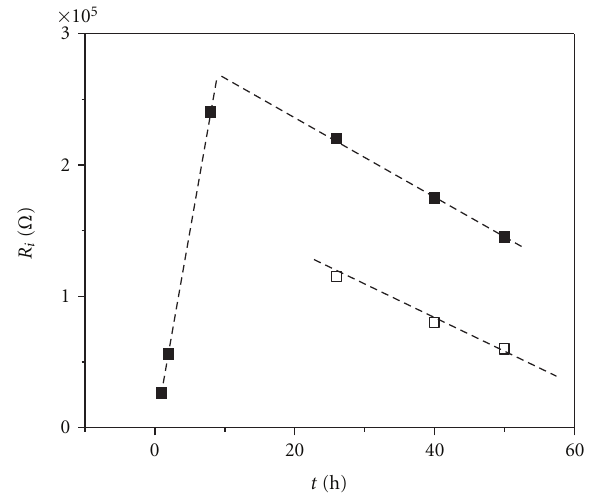
Figure 10: Time dependence of the electrical resistance of ( (cid:4) ) bulk membrane, ( (cid:5) )